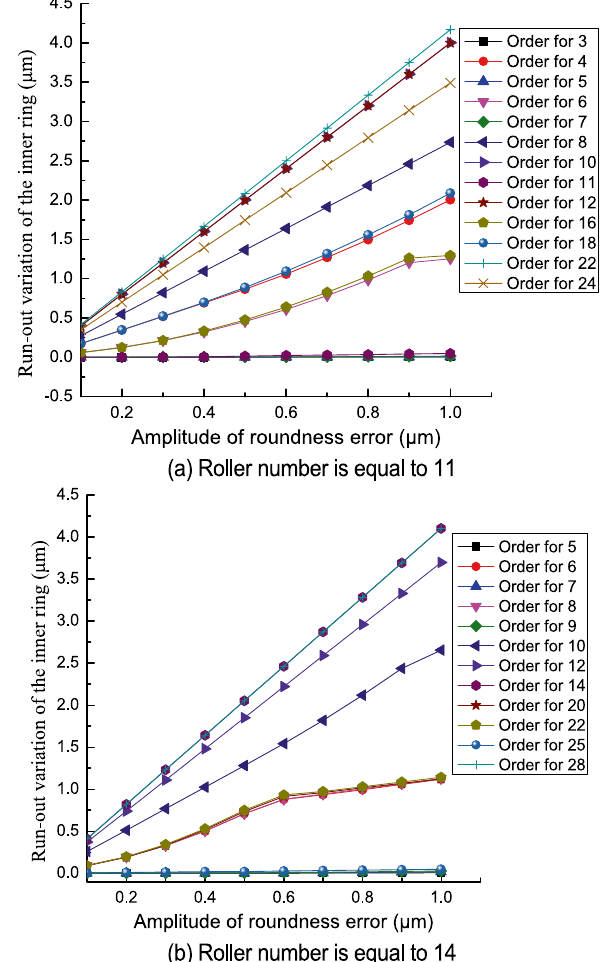
Figure 14. Effect of the amplitude of roundness error in the rollers on the run-out variation of the inner